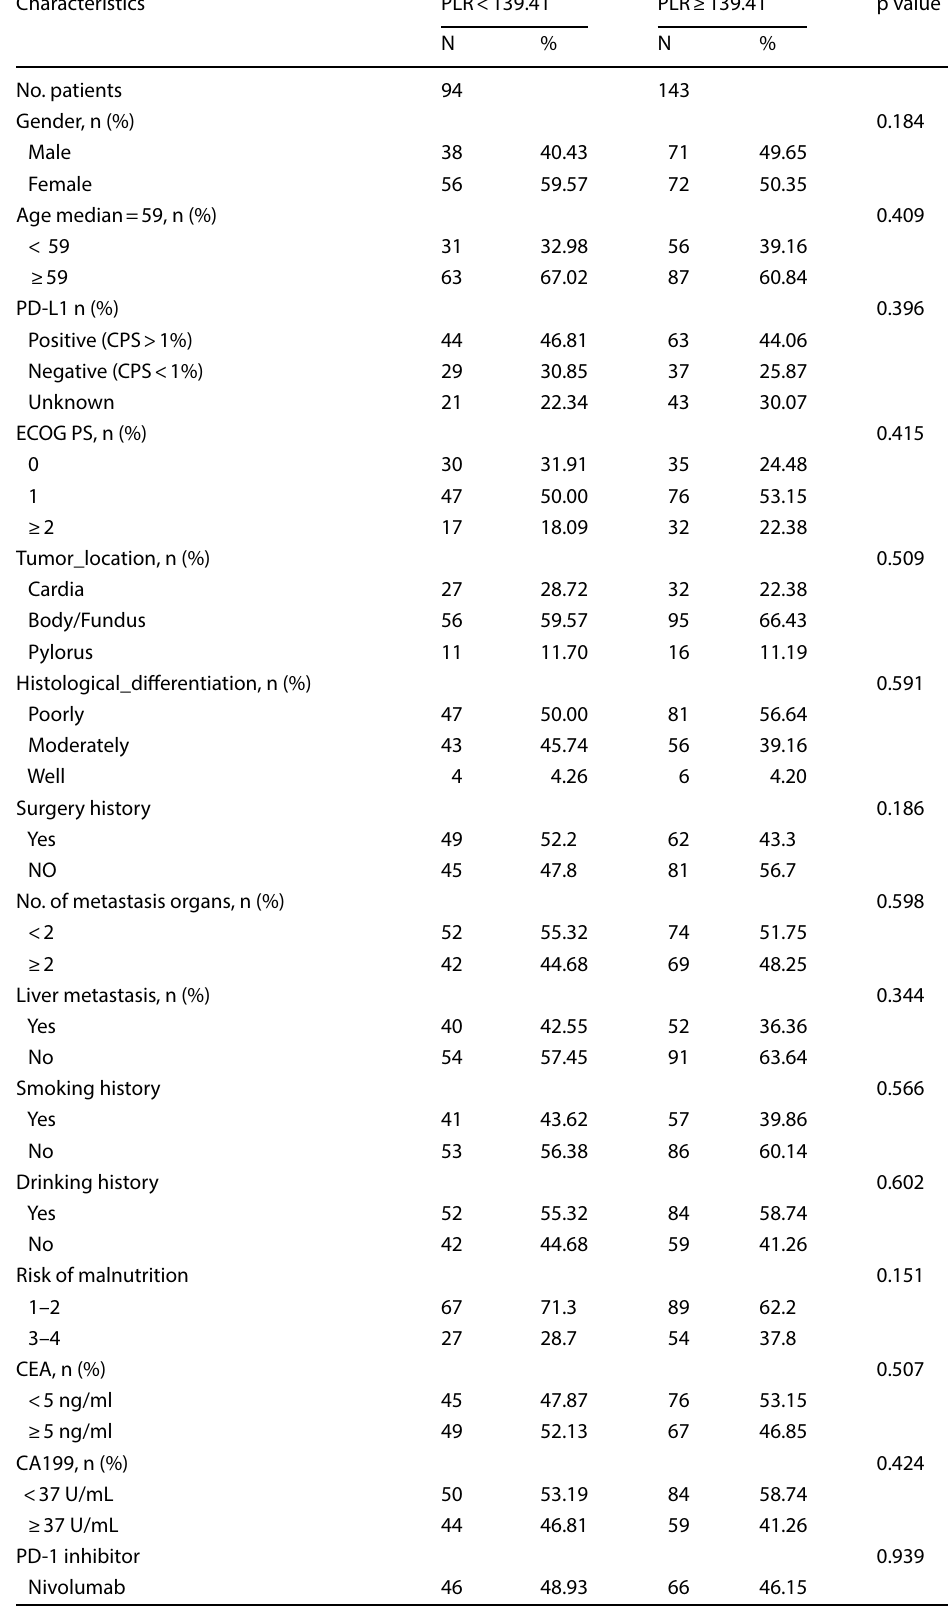
Table 1 The characteristics of the analyzed patients in different groups